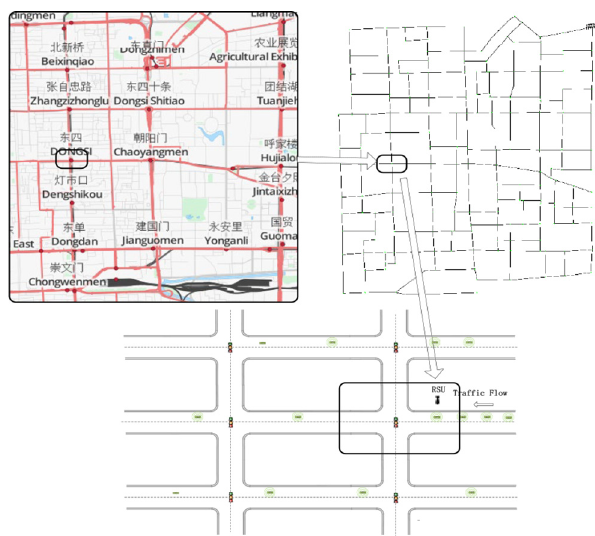
Figure 7 Simulation fl ow diagram